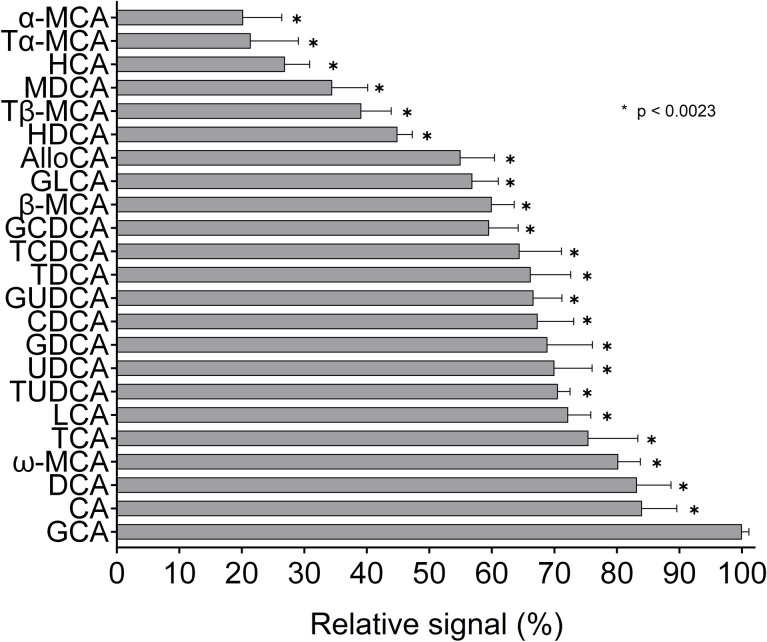
Relative signal intensities for individual BAs determined by an enzymatic method.Individual BAs were analyzed using an enzymatic kit, and the obtained signal was expressed as a % of the reference (GCA). Measurements were performed three times at three concentrations (20, 50, and 100 μmol/L)—each bar thus represents the average of nine values. All values differ significantly from reference: p <0.0023 (original p-value of <0.0001 was adjusted for 23 comparisons using Bonferroni correction).